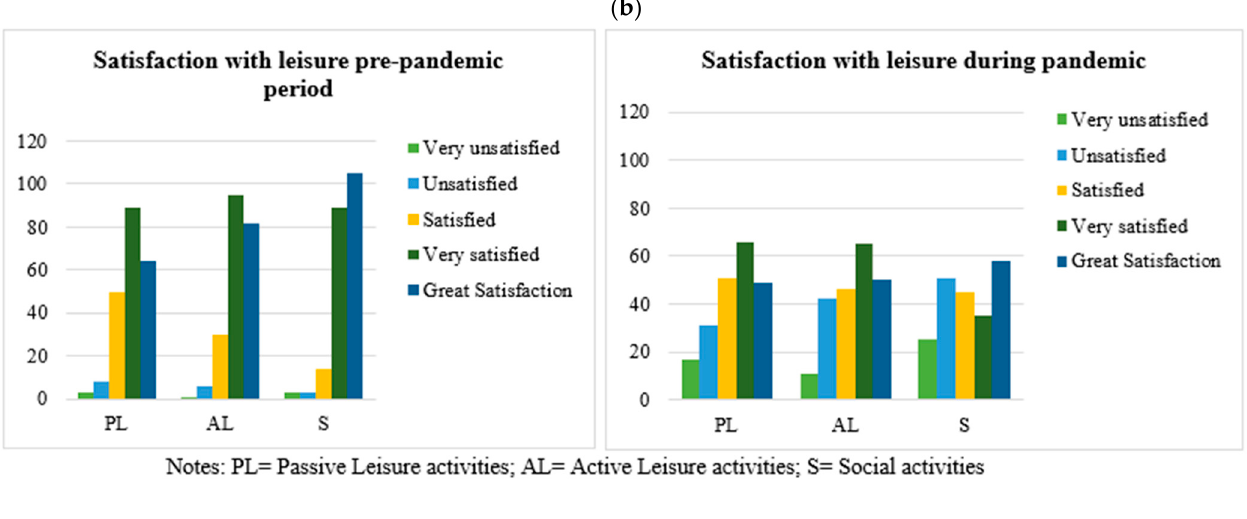
Figure 4. ( a ) Satisfaction with daily activities performance. ( b ) Satisfaction with productivity per-